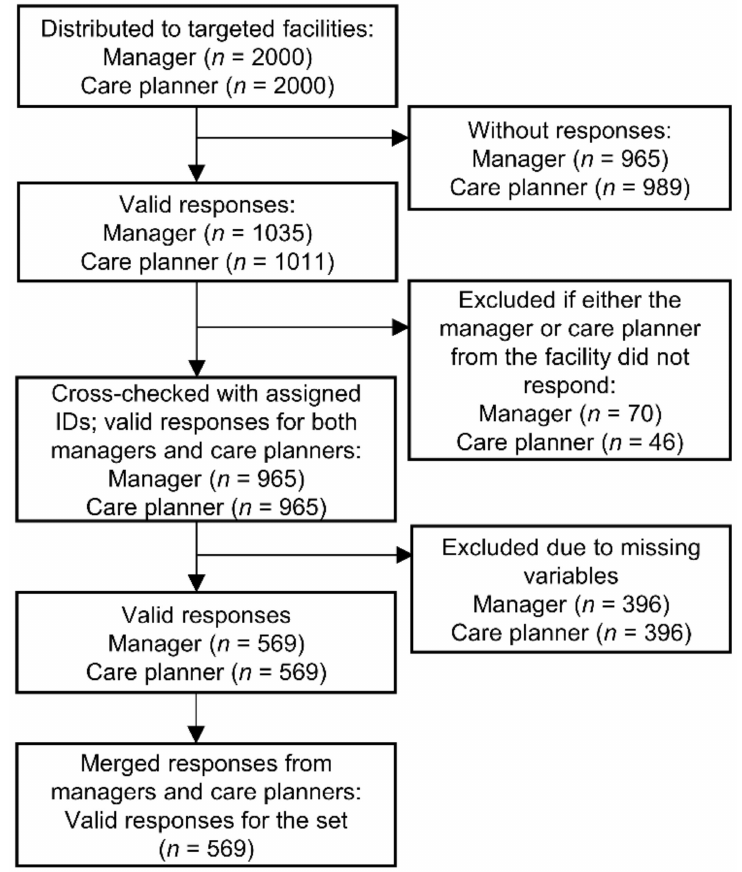
Figure 1. Flow chart of the study